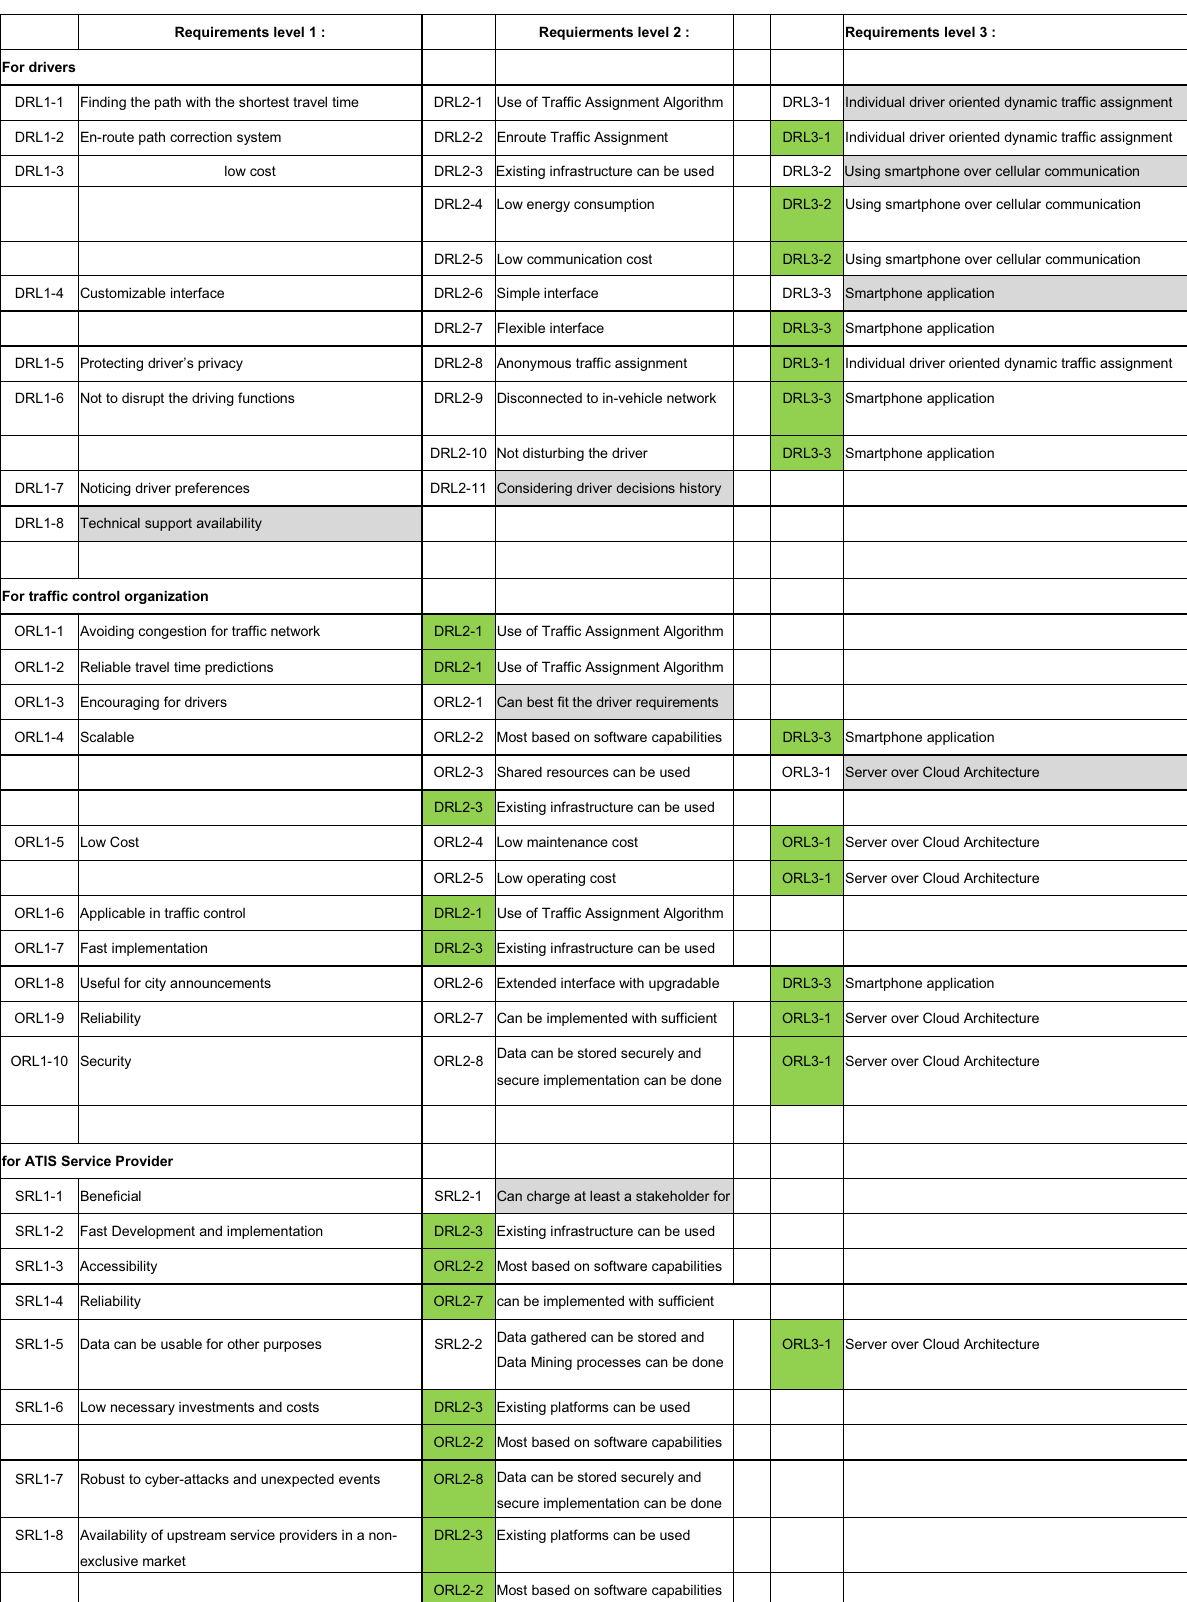
Table 1 Stakeholders’ requirements list in hierarchical scheme :3levelstnemeriuqeR:2levelstnemreiuqeR:1levelstnemeriuqeR For